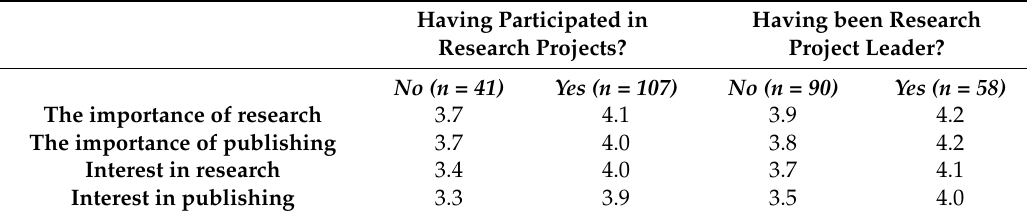
Table 4. Mean scores according to lecturers’ involvement in research projects.